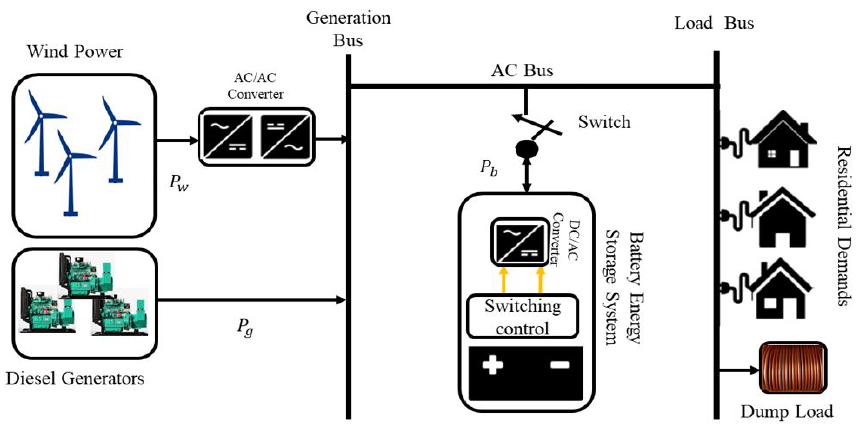
Figure 2. The proposed microgrid